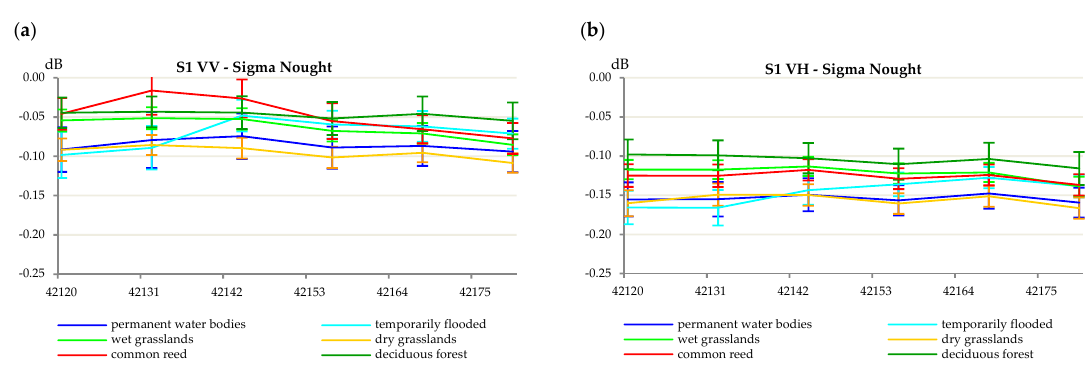
Figure 10. Sigma nought (dB) ( a ) at VV and ( b ) VH polarizations (mean and standard deviations) for the time series of Sentinel-1A acquisitions for the final six thematic classes.